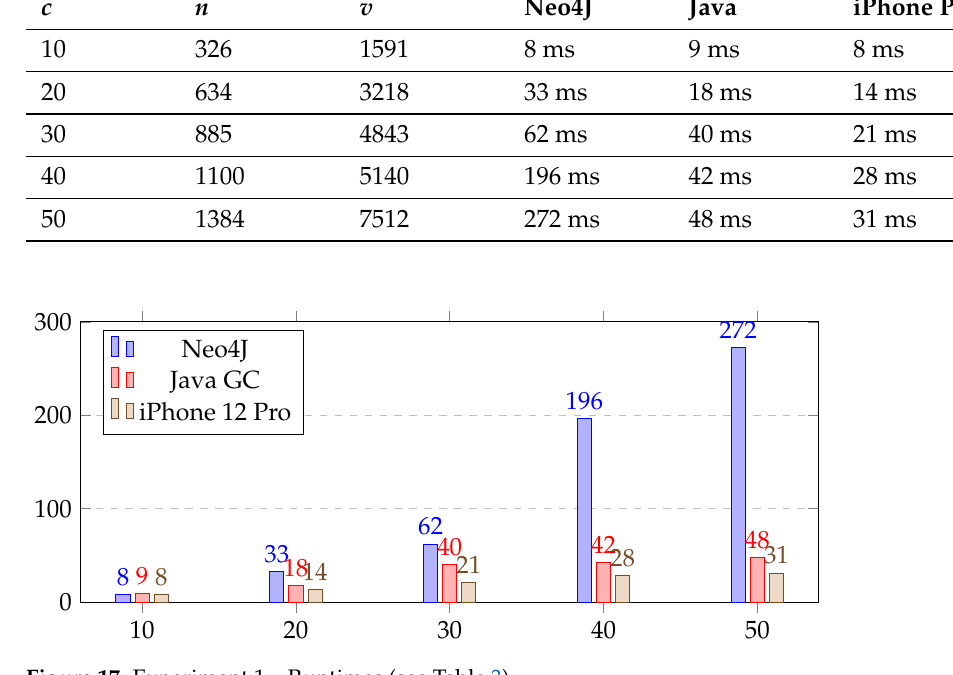
Figure 17. Experiment 1—Runtimes (see Table